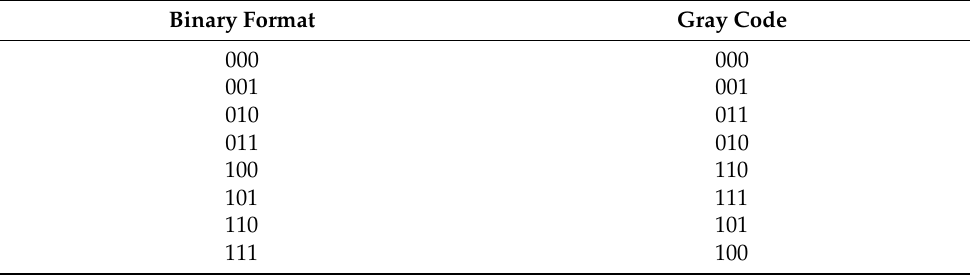
Table 1. Illustrative example of 3-bit Gray code equivalence.